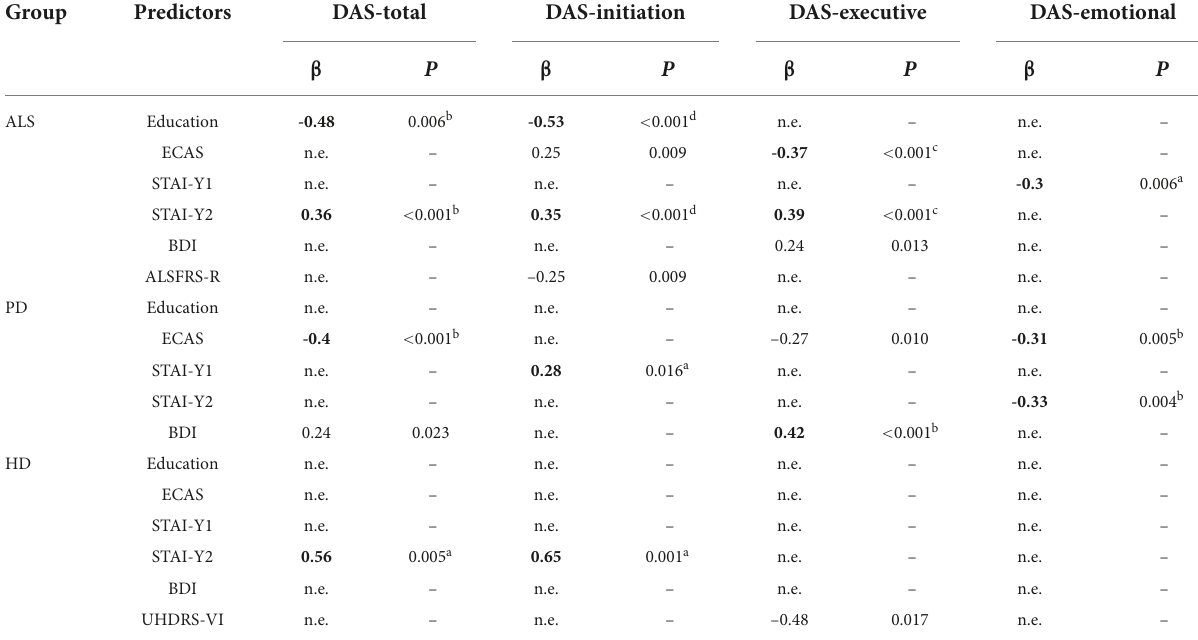
TABLE 2 Determinants of dimensional apathy scale (DAS) scores in amyotrophic lateral sclerosis (ALS), Parkinson’s disease (PD), and Huntington’s disease (HD) patients. Group Predictors DAS-total DAS-initiation DAS-executive DAS-emotional